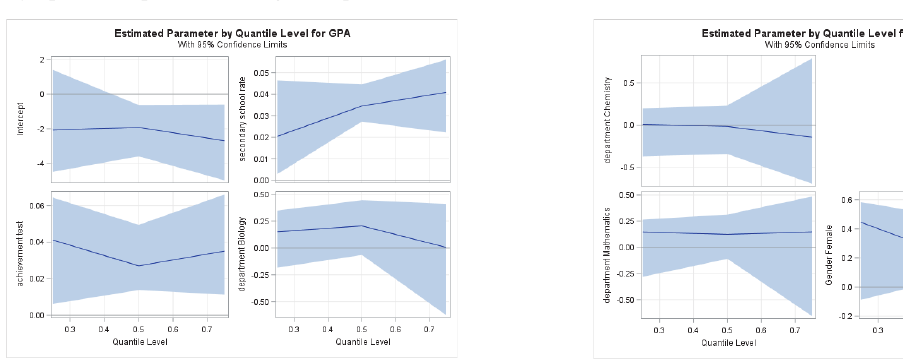
Fig. 2. Quantile processes with 95% band for secondary Fig. 3. Quantile processes with 95% band for department of